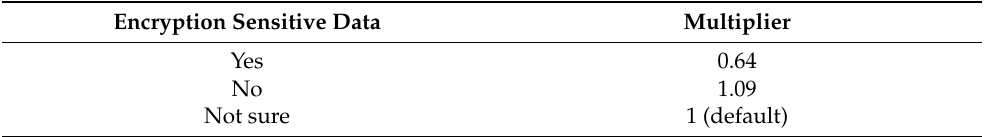
Table 16. Probability factor—sensitive data encryption F E